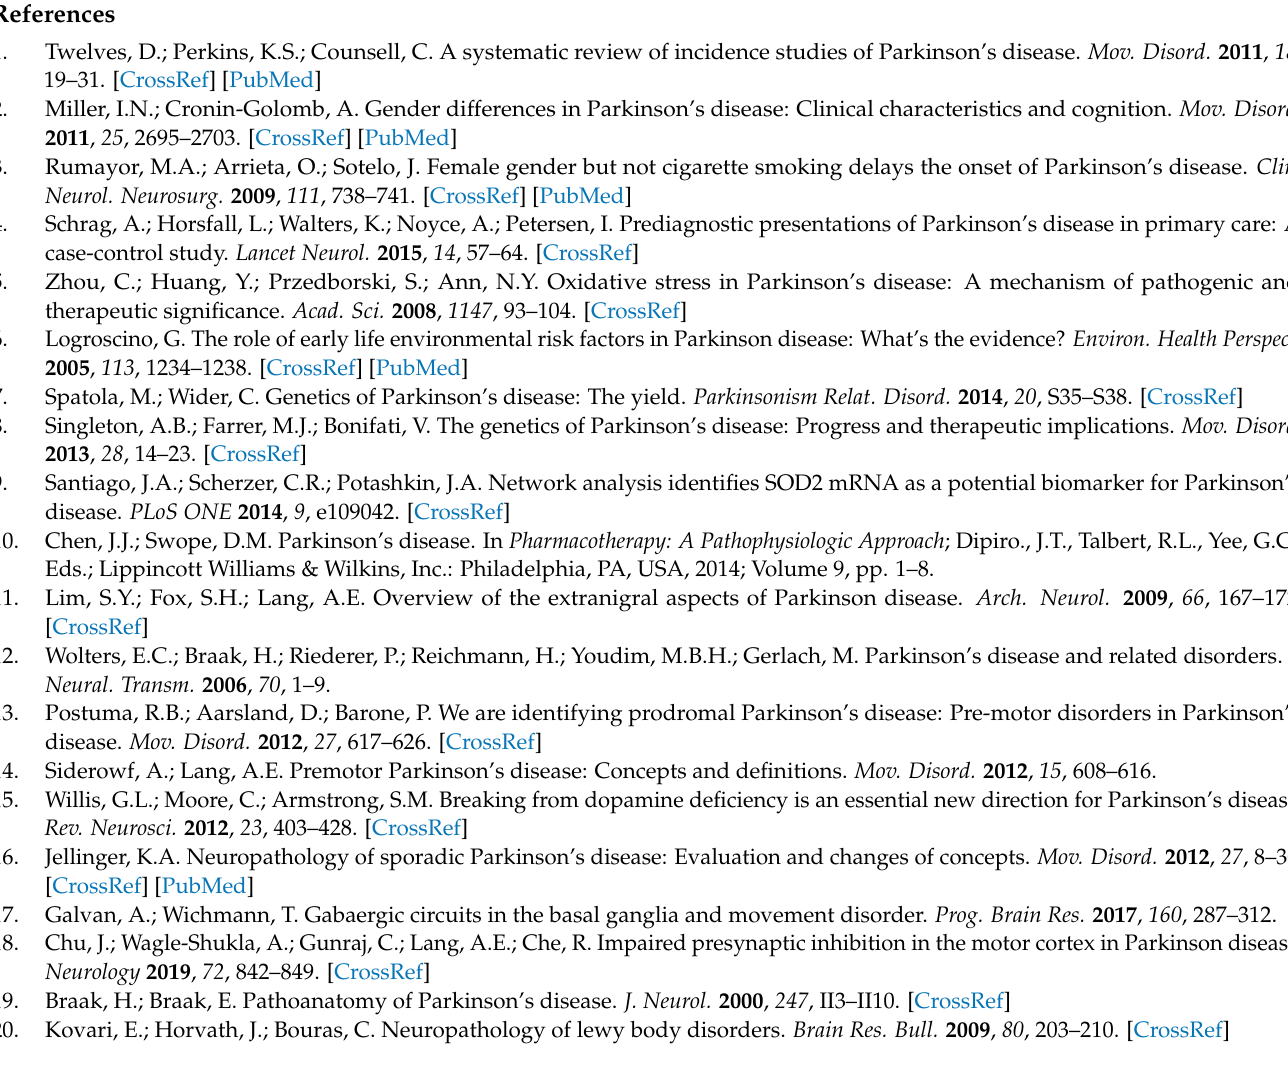
Figure S3: Mass spectra, Text S1: Supplementary procedure for toxicity evaluation, Table S1: Inhibitions of AChE, BChE, and BACE-1 by DM series. Refs. [64–67] are cited in Supplementary